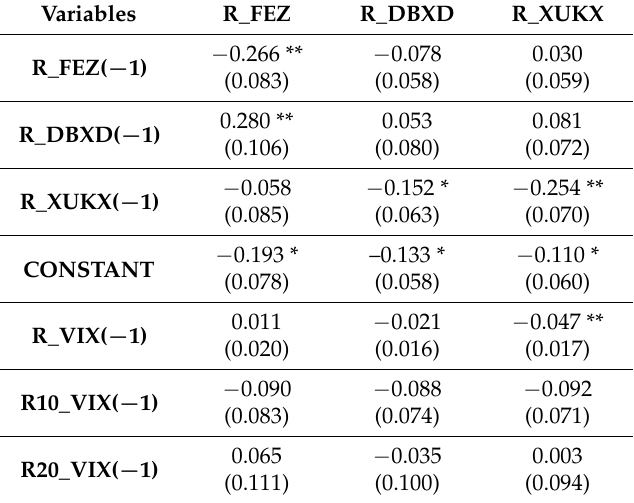
Table 12. Mean Equation for European Market ETF and VIX (During GFC) (1 November 2007 to 31 March 2009).